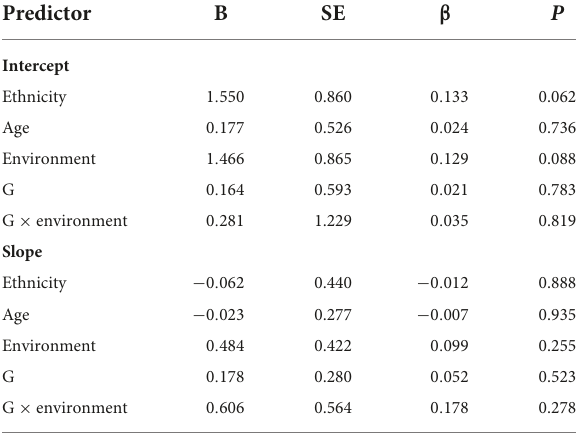
TABLE 6 Main and gene–environment interaction effects of rs2267735 on the course of posttraumatic stress disorder symptoms between 2.5 and 5.5 years after the earthquake (in boys).